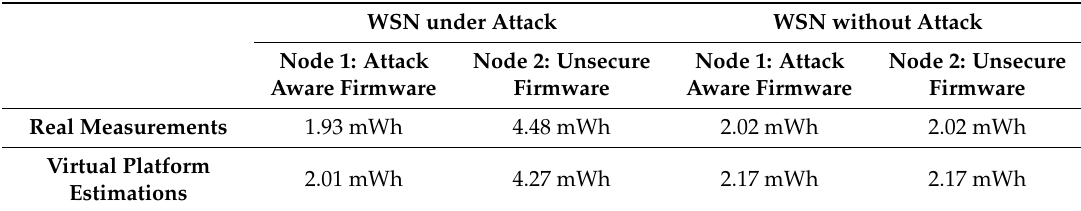
Table 8. Real/Simulation Consumption Results for WSN.